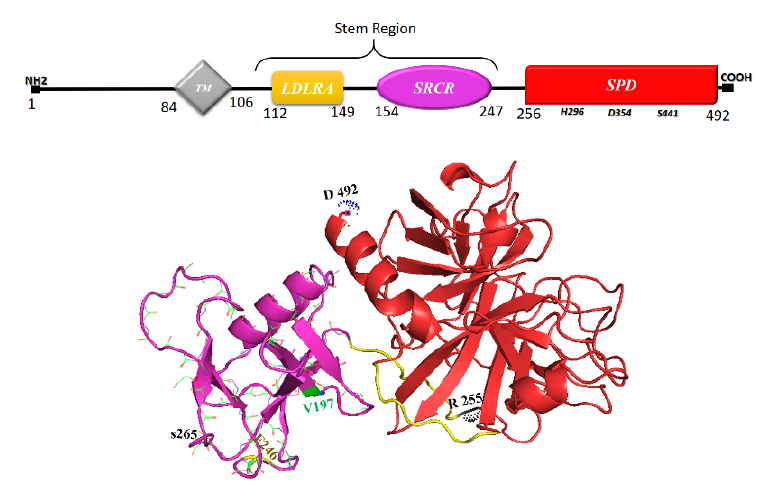
Figure 3. Linear representation of distinct domains and three dimensional shape of human TMPRSS2 (isoform 2) (PDB ID: 7MEQ [18], PyMol molecular graphics system).